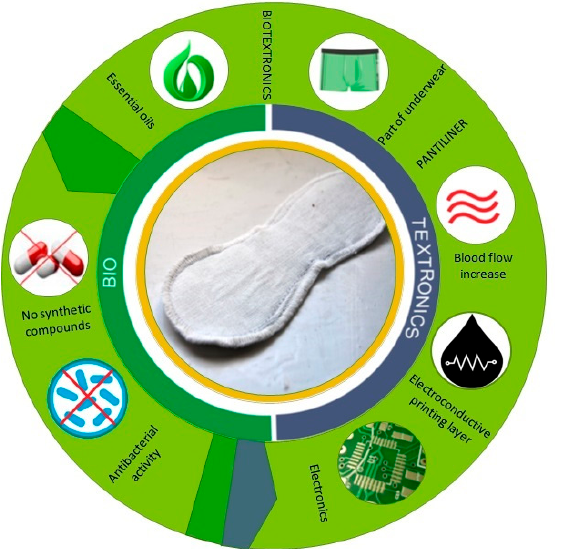
Figure 1. Functionality of the biotextronics system.